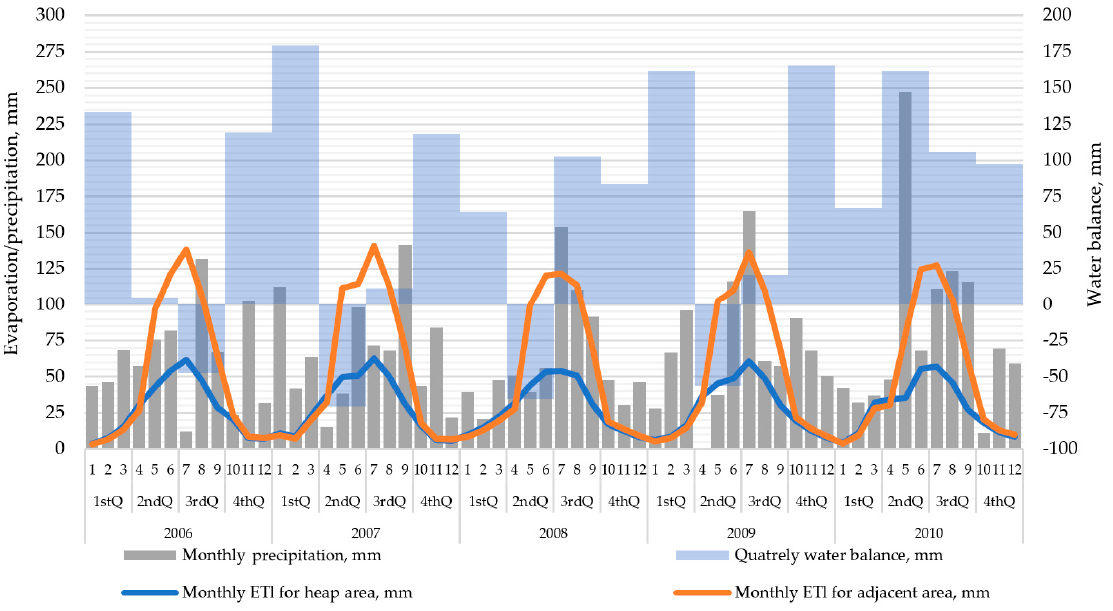
Figure 7. Landscape evapotranspiration and water balance for heap and adjacent areas in the period 2006-2010.